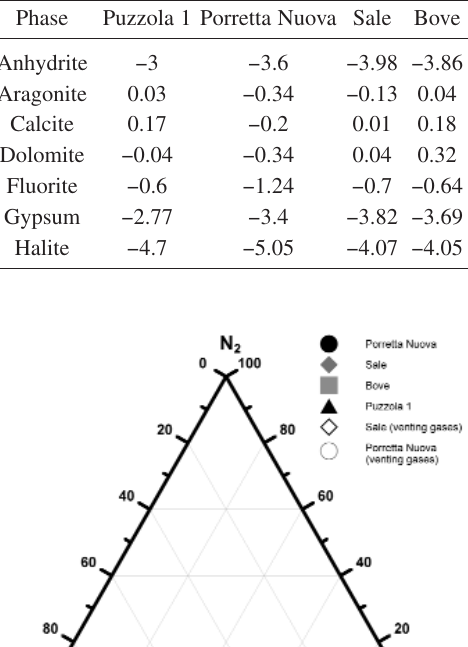
Table III. Saturation indexes (SI) calculated for the main mineralogical phases in equilibrium with the thermal waters. It is evident how aragonite and cal- cite are close to the saturation showing the attain- ment of the equilibrium for the less saline waters (Puzzola 1 and Porretta Nuova, new thermal plant), while more concentrated waters (Sale and Bove, old thermal plant) are equilibrated with calcite and dolomite. SI calculated by the WATEQP software (Appelo, 1988) and expressed as the logarithm of the ion activity ratio pertinent to a mineralogical phase, and the equilibrium constant of its solubility product.